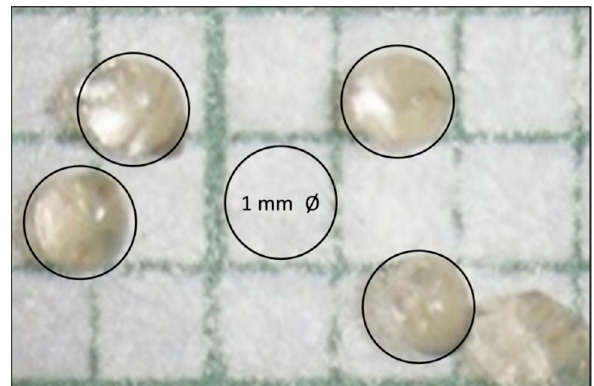
Figure 4. The photograph at 80× of CS spheres obtained from the optimal formulation (R.H. 10%).